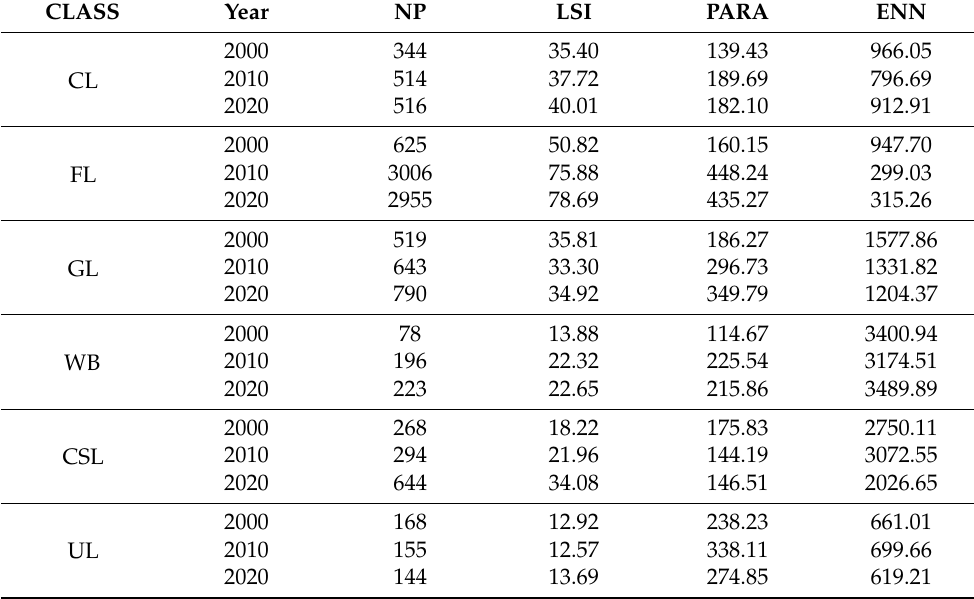
Table 7. Variations of landscape metrics for different LUC